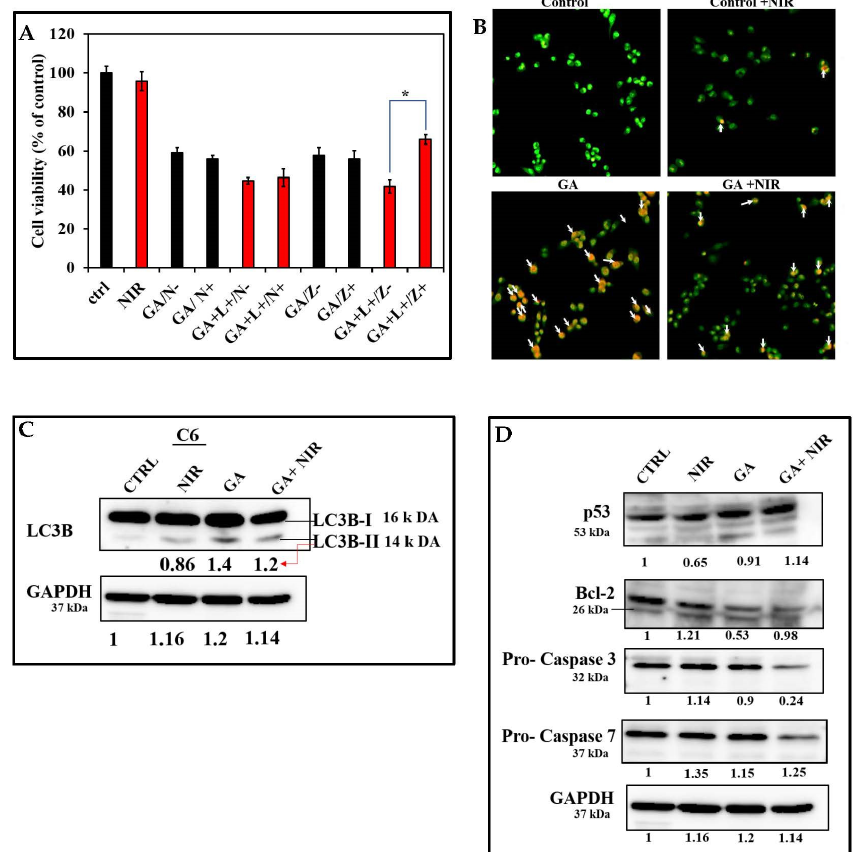
Figure 8. Cell-death patterns of C6 cells treated with GNR-ANGI-2 under laser or sham exposure. ( A ) Cell cytotoxicity pattern of C6 cells preincubated with caspase (Z-VAD) inhibitor or RIPK1 (Nec-1) inhibitor for 4 h and irradiated with laser (12 min); cell viability was evaluated using the MTT assay; cells treated with media were used as control. The bar graph represents the percentages of cell viability respective to the treatment conditions. Error bars represent the standard deviations of 3 experiments ( n = 3, * p < 0.05). ( B ) C6 cells incubated with medium (control), laser (control+ NIR), GNR-ANGI-2 (GA), and GR-ANGI-2 (GA+NIR) were treated with 5 μ g/mL AO for 30 min; then, images were recorded under fluorescence microscopy. Red fluorescence (white arrows) indicates acid vesicular organelles stained with acridine orange within the cells. ( C ) LC3-II processing in C6 cells treated with GNR-ANGI-2 under laser or sham exposure, and control and control treated with laser incubated for 24 h using Western blotting. ( D ) Changes in protein expression in C6 cells treated with GNR-ANGI-2 under sham or laser exposure. Representative Western blot results show the expression of p53, caspase-3, caspase-7, and Bcl-2 proteins. ImageJ was used to analyze the fold change in protein expression.